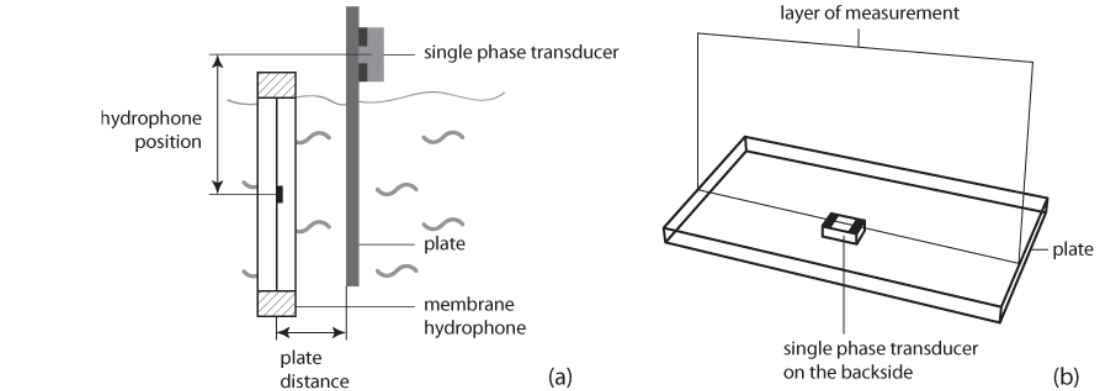
Figure 8. (a) Measurement setup for membrane hydrophone measurements. (b) The emission profile is measured in the plane orthogonal to the plate and centered orthogonal to the finger structure of the single-phase transducer.